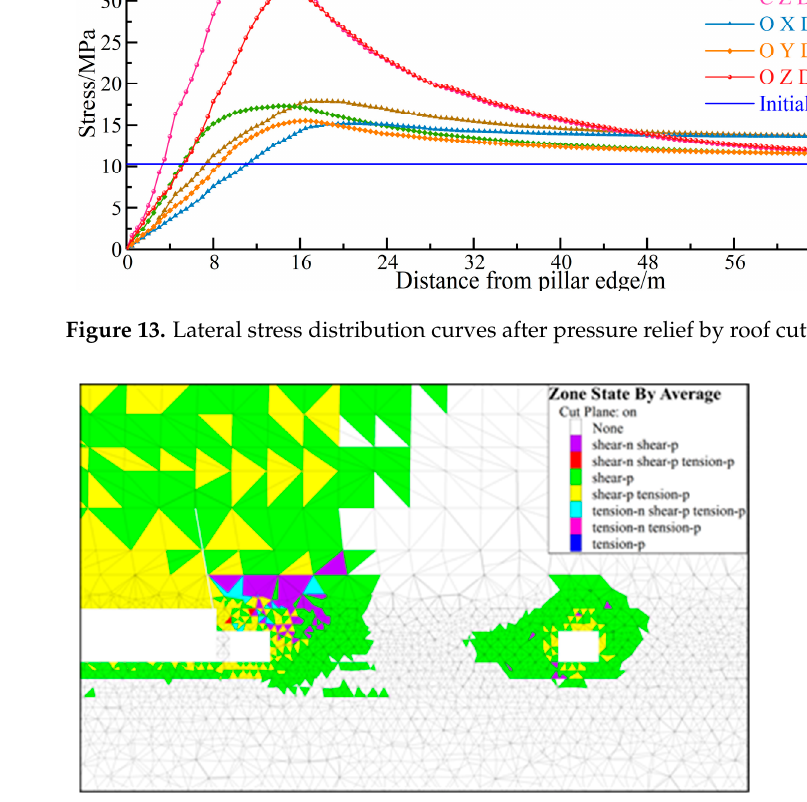
Figure 13. Lateral stress distribution curves after pressure relief by roof cutting.